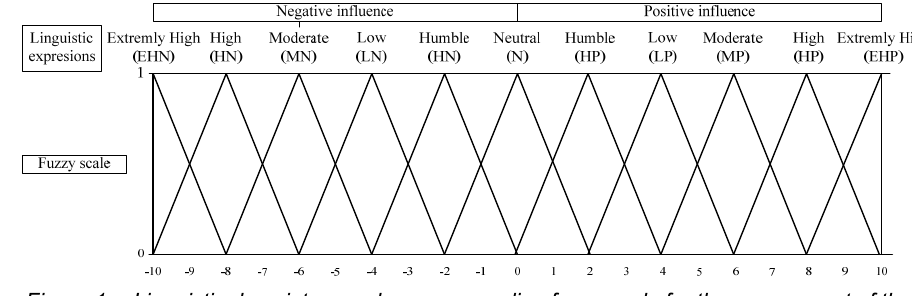
Figure 1 – Linguistic descriptors and a corresponding fuzzy scale for the assessment of the influence of the strategic